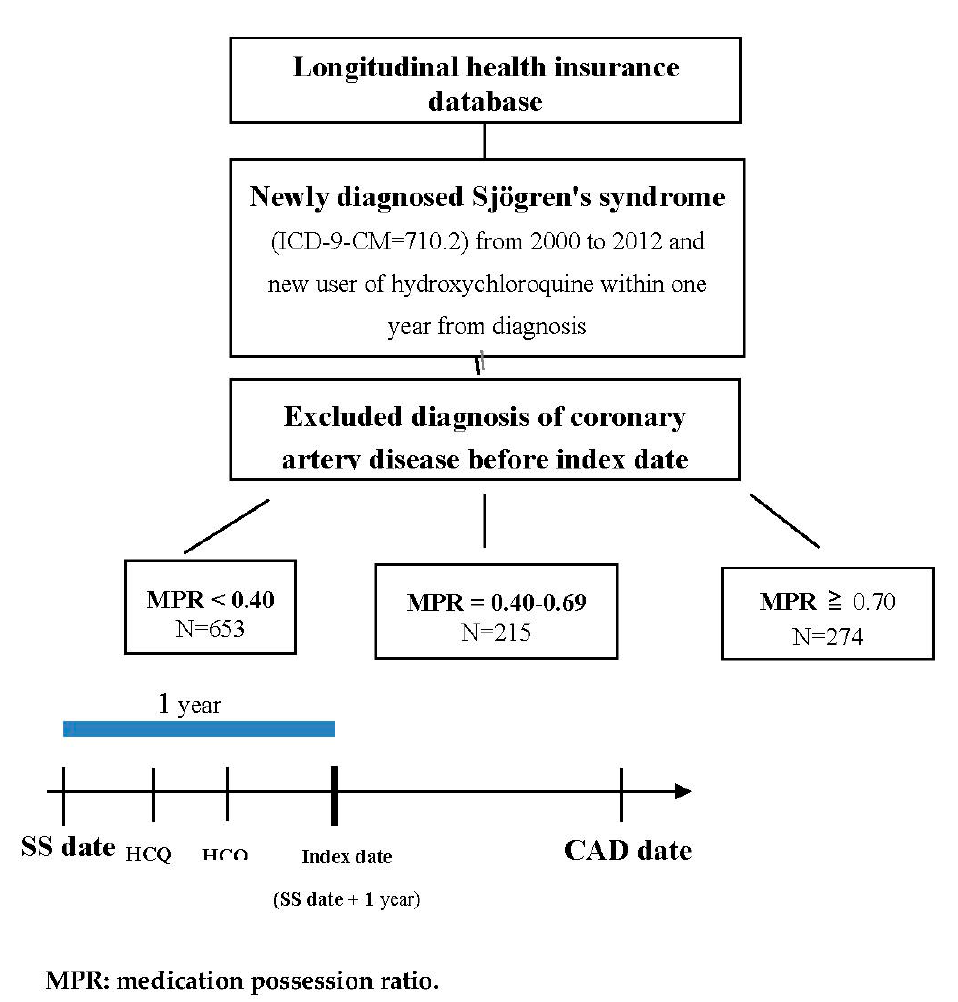
Figure 1. The study flow chart to identify these Sjögren’s syndrome (SS) patients .